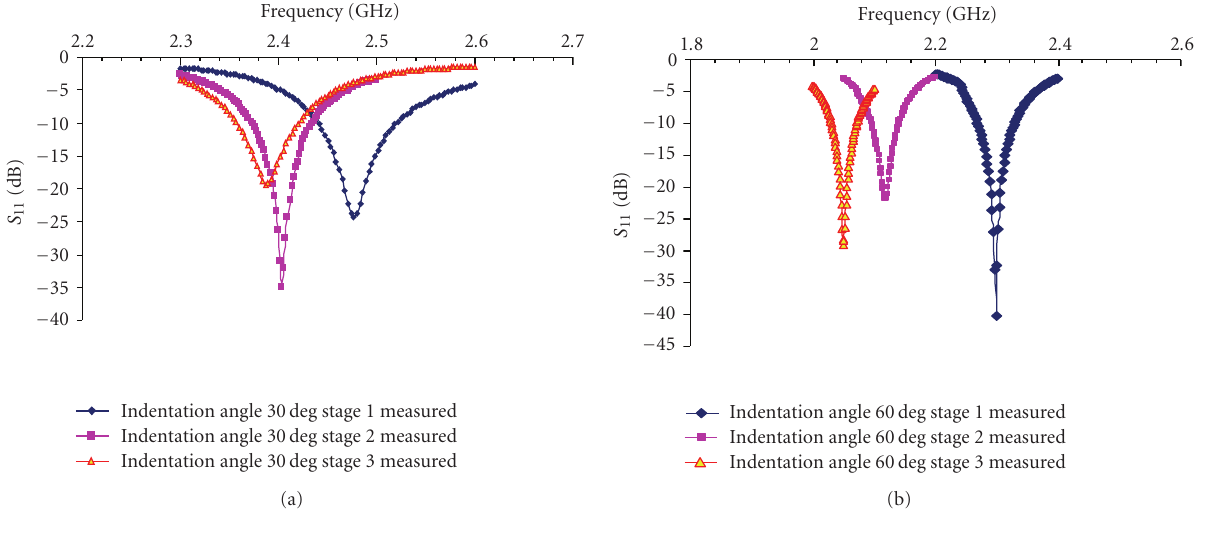
Figure 8: (a) Measured S 11 characteristics fractal boundary antenna with indentation angle 30 ◦ . (b) Measured S 11 characteristics fractal boundary antenna with indentation angle 60 ◦ . Table 5: Bandwidth comparison of antennas operating at the same frequency of 2.5